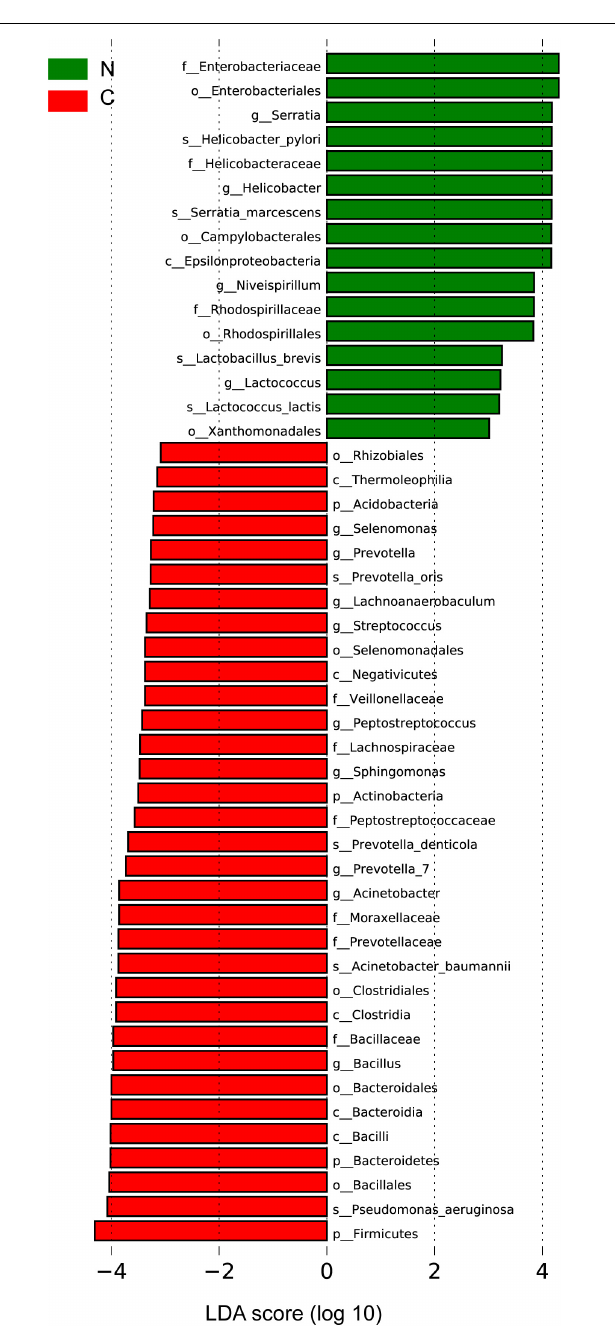
were observed in the non-cancerous tissue network, with Pseudomonas as the interaction node. These interactions occurred among Pseudomonas and Serratia , Lactobacillus , Lactococcus , Staphylococcus , as well as